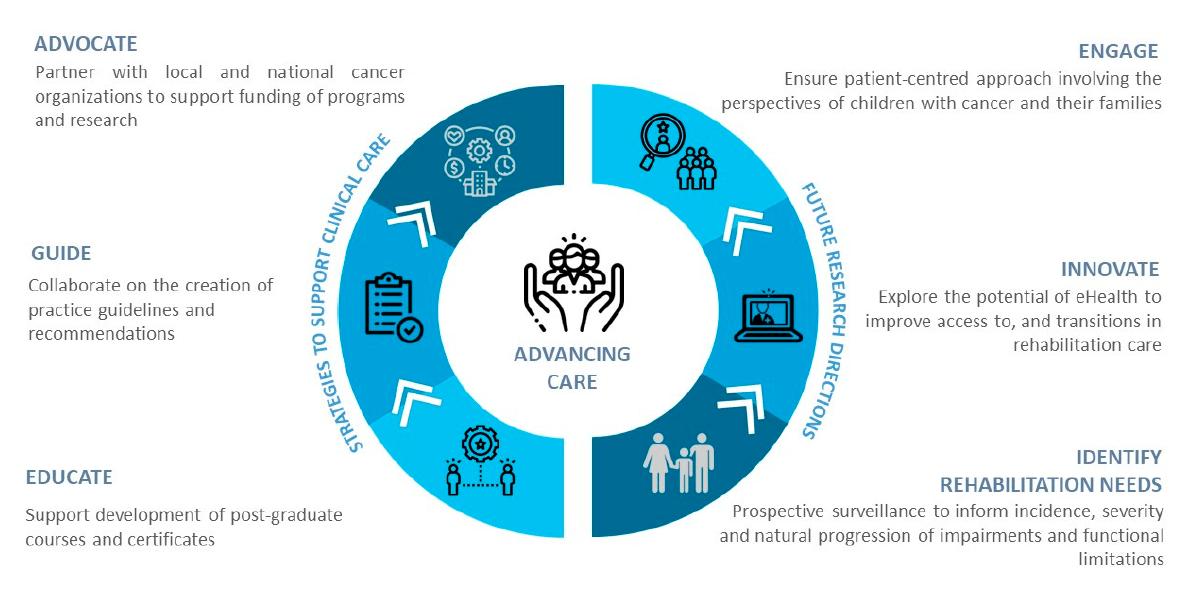
Figure 3. Figure 3. Framework to advance clinical care and guide future research in pediatric oncology rehabilitation.